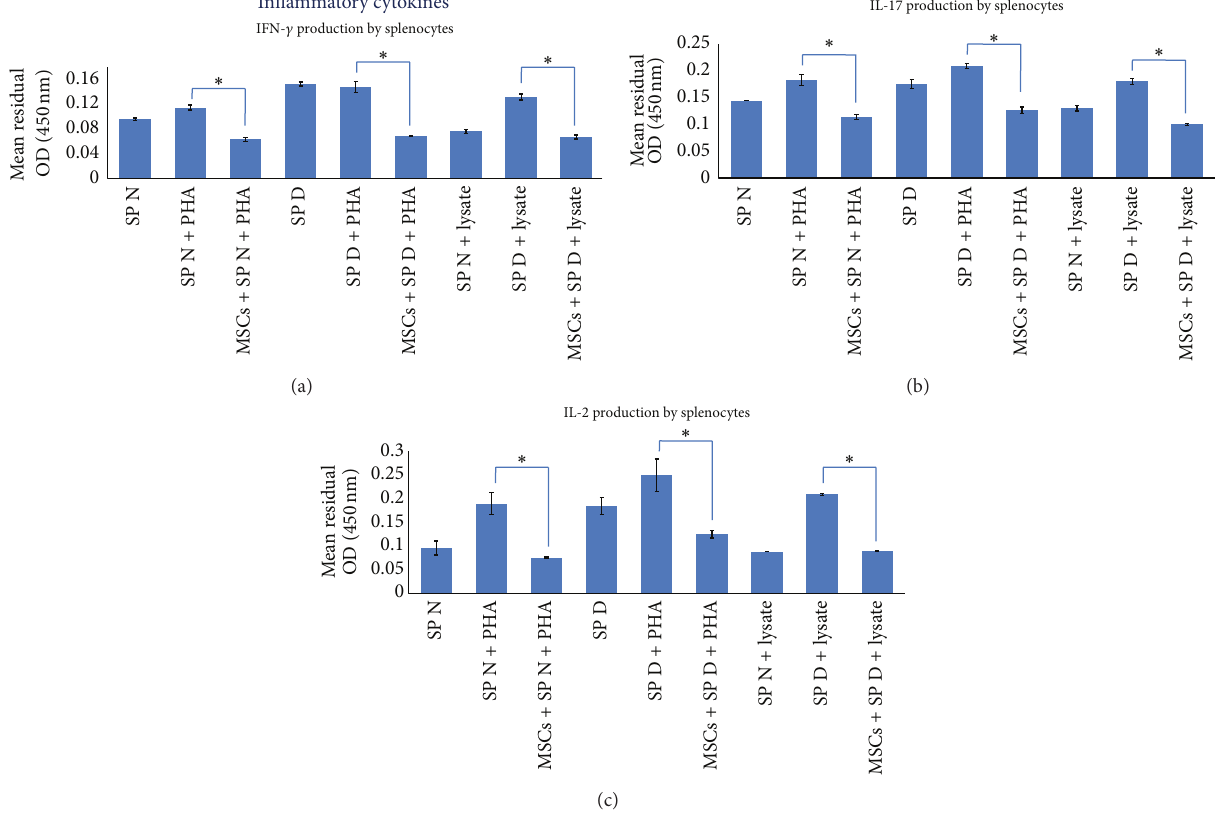
Figure 4: The immunomodulatory effects of AT-MSCs at passage 3 on inflammatory cytokines produced by splenocytes. Addition of AT- MSCs to islet, or PHA, stimulated splenocytes decreased IFN- 𝛾 , IL-2, and IL-17 production by splenocytes ((a), (b), and (c)). Background absorbance of cytokines produced by AT-MSCs was subtracted. Thus, the representative results show splenocytes related cytokines pattern. Data presented the mean ± SD of five independent experiments. ∗ indicates significant difference between groups ( 𝑃 < 0.05 ). SP N: normal splenocytes; SP D: diabetic splenocytes; PHA: phytohemagglutinin; lysate: pancreatic islet cells